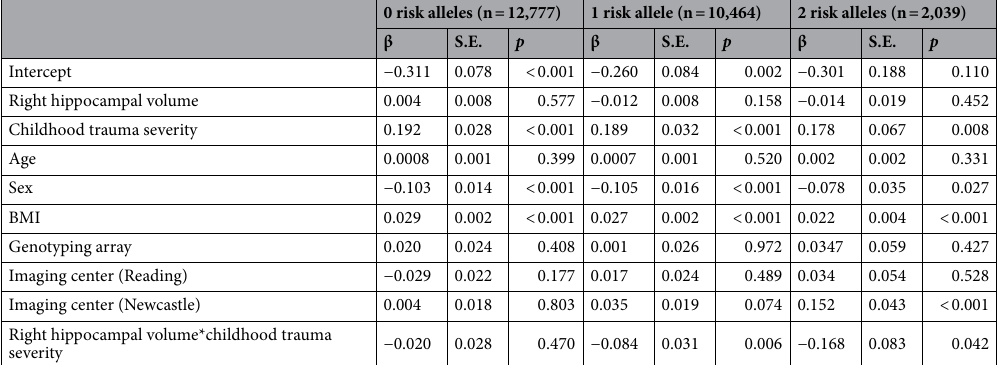
0 risk alleles (n = 12,777) 1 risk allele (n =